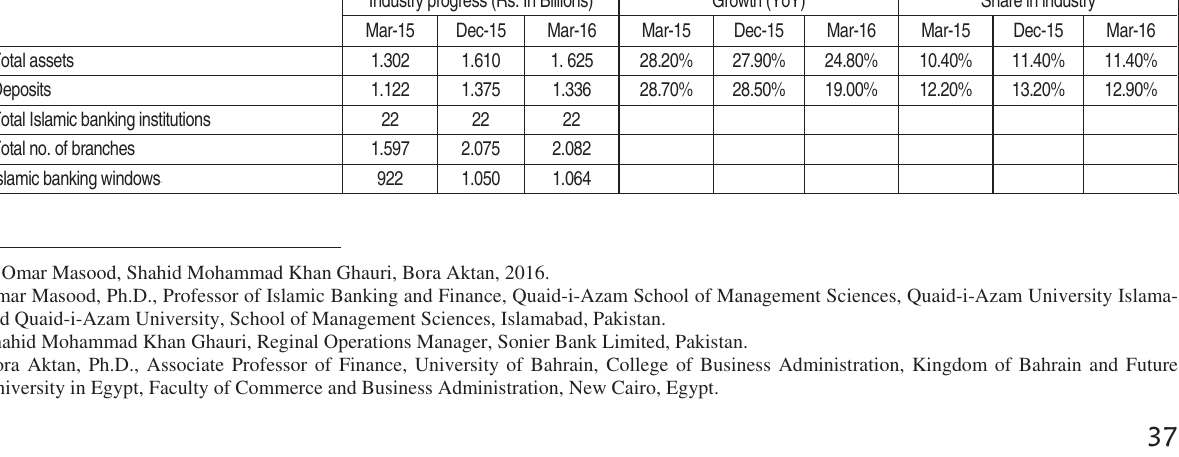
Table 1. Industry progress and market share in Pakistan (SBP Islamic Banking Quarterly Bulletin, 2016) Industry progress (Rs. In